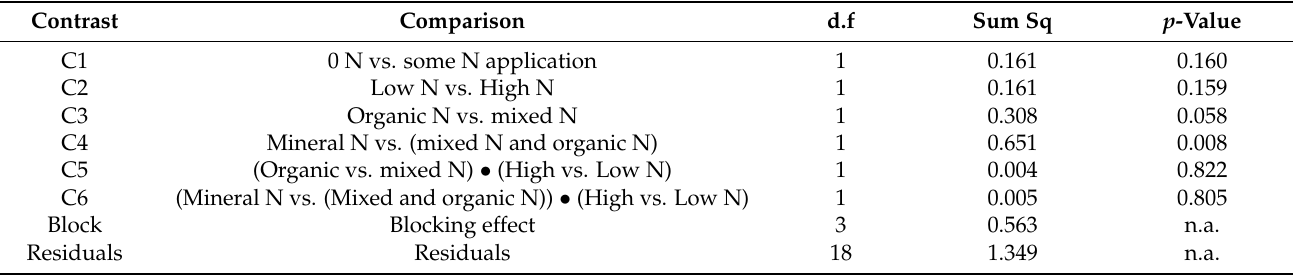
Table 10. ANOVA of contrasts showing effect of N management strategy on grain Fe concentration of the low Fe finger millet “seed pool” grown in Hwedza.